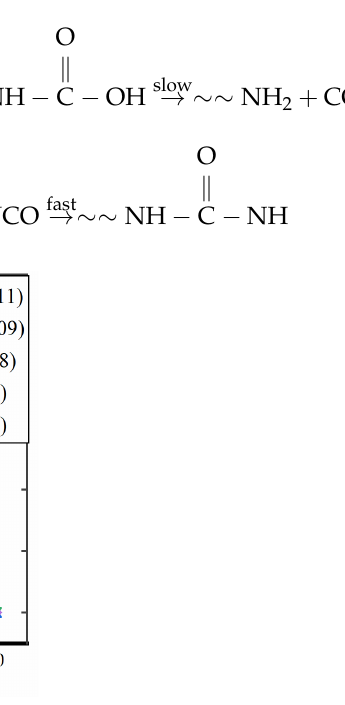
Figure 1. The relationship between foaming agent (water) and density (normalization) [17,19–